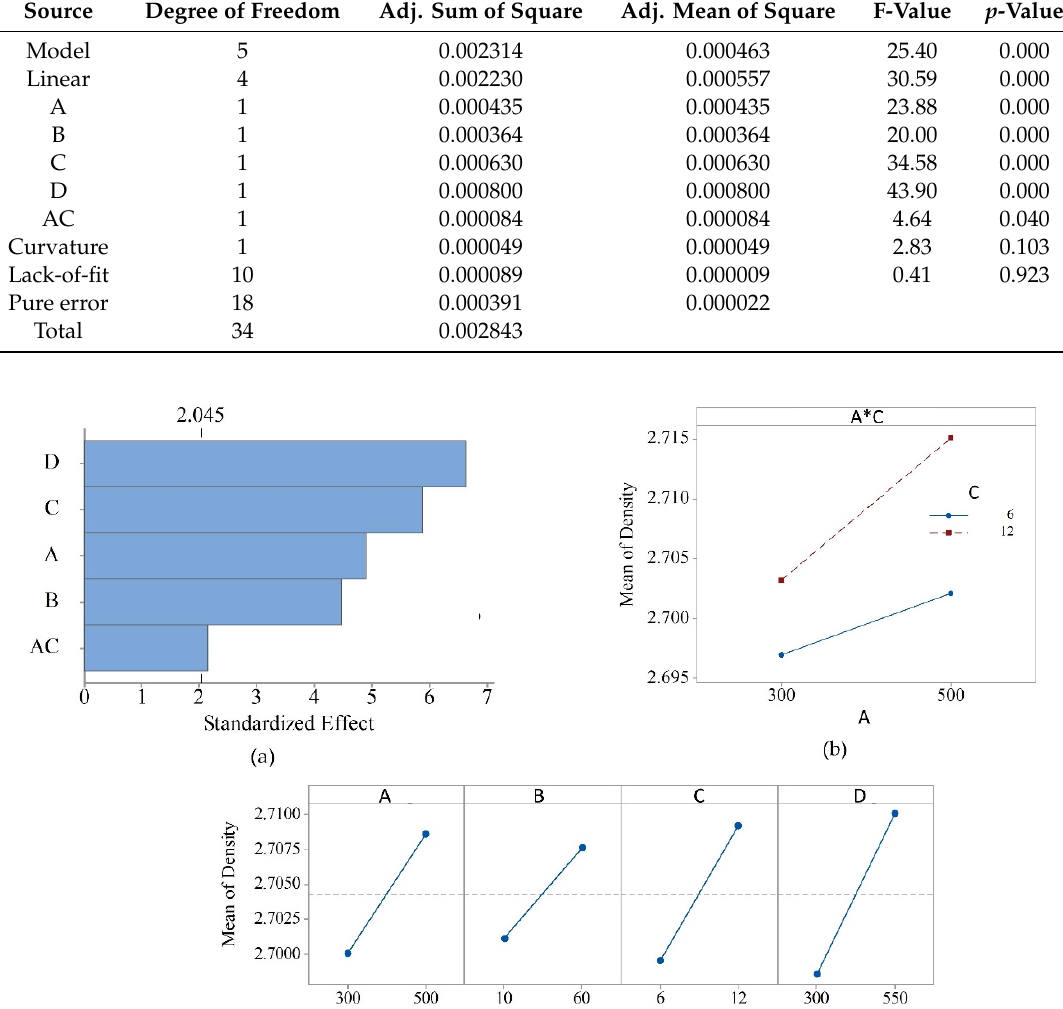
Table 3. ANOVA results after backward elimination.